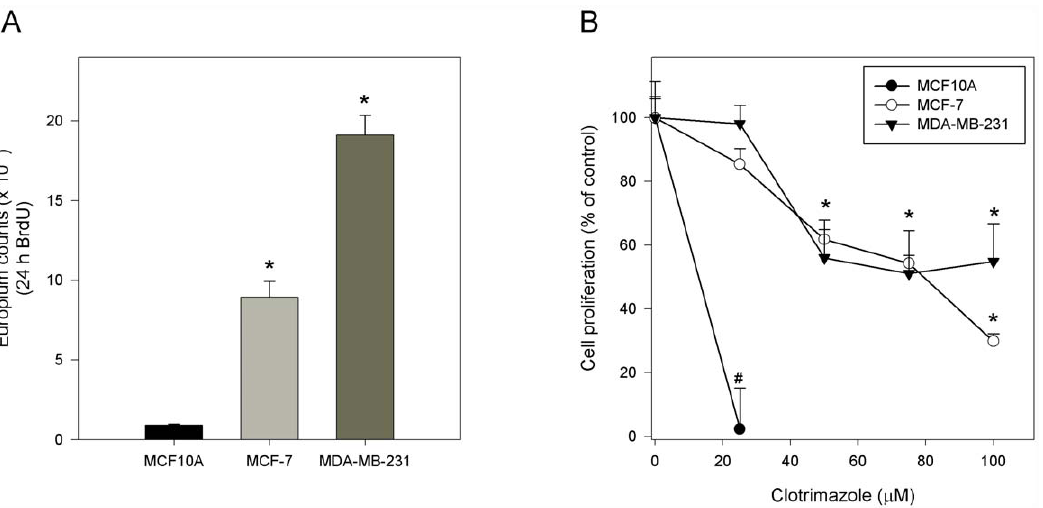
Figure 2. Clotrimazole decreases cell proliferation of MCF10A, MCF-7 and MDA-MB-231 cells. (A) Basal cell proliferation of human breast cell lines was analyzed using the BrdU incorporation assay. The graph shows the europium-based TRF cell proliferation assay. * P , 0.05, in comparison with MCF10A cell line. (B) Effects of clotrimazole on cell proliferation after 24 h treatment using BrdU incorporation assay. Values are mean 6 standard error (SE) of four different experiments. # P , 0.05, in comparison with the control; * P , 0.05, comparing 50, 75 and 100 m M clotrimazole with the control in the absence of the drug for both cell lines (MCF-7 and MDA-MB-231).